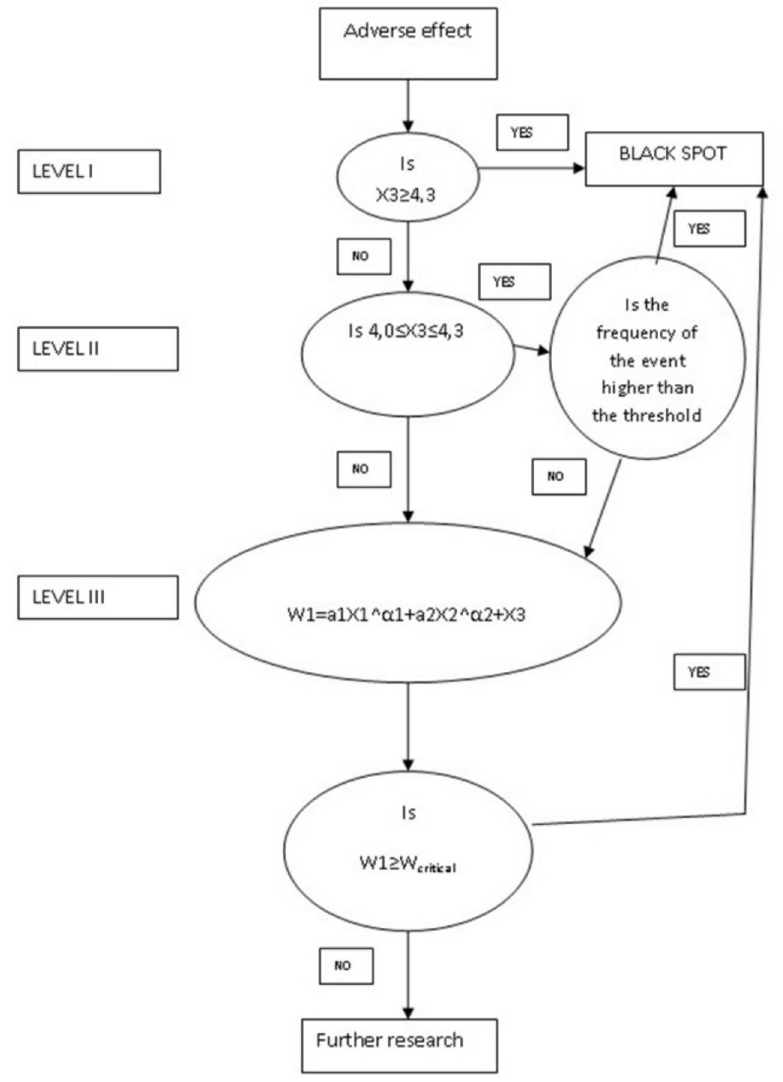
Figure 1. Model of the procedure used for the determination of black spots. Source: (Sierocka et al., 2011)